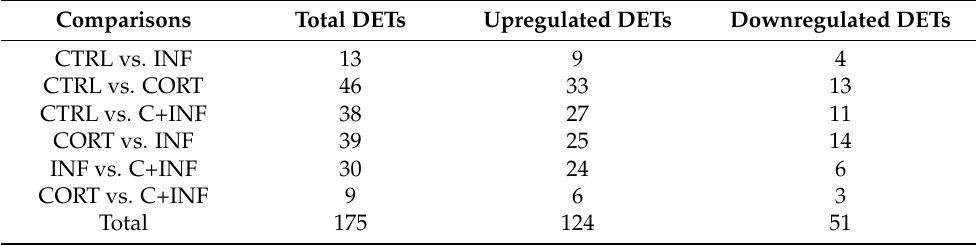
Table 1. The number of differentially expressed transcripts (DETs) in rainbow trout myotubes treated with cortisol and/or infected with P. salmonis . The table showed the number of total DETs, upregulated, and downregulated between all comparisons. Abbreviations: CTRL, control; CORT, cortisol; INF, infection; C+INF, cortisol+infection. Comparisons Total DETs Upregulated DETs CTRL vs. INF